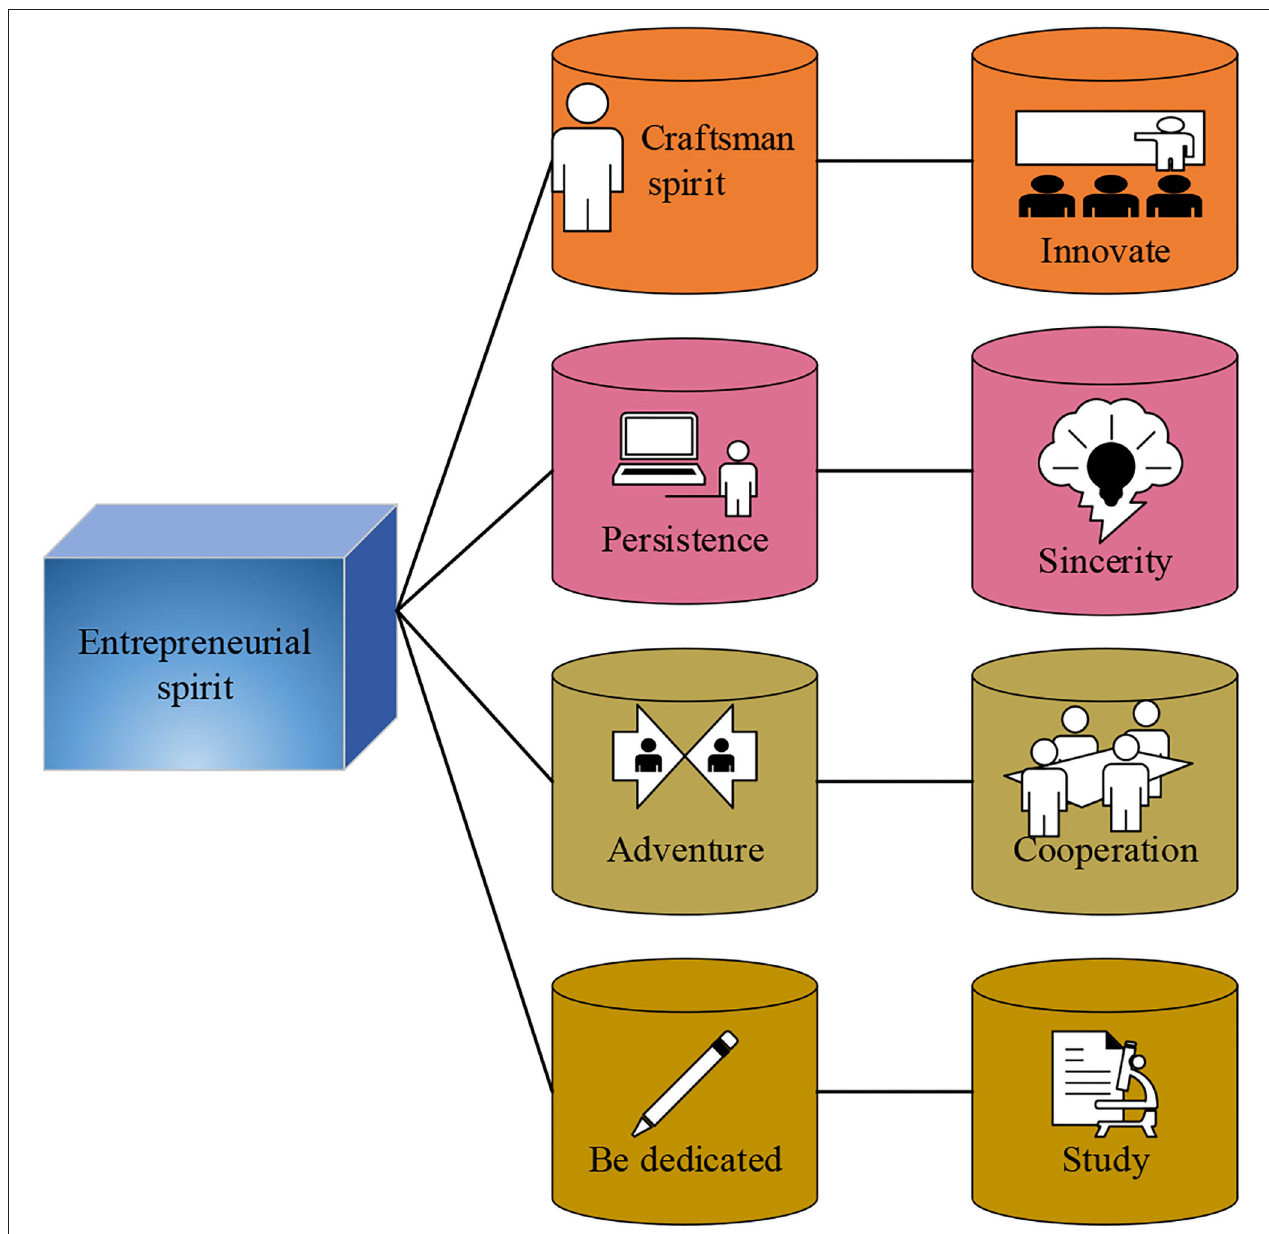
FIGURE 6 | The characteristics of true entrepreneurial